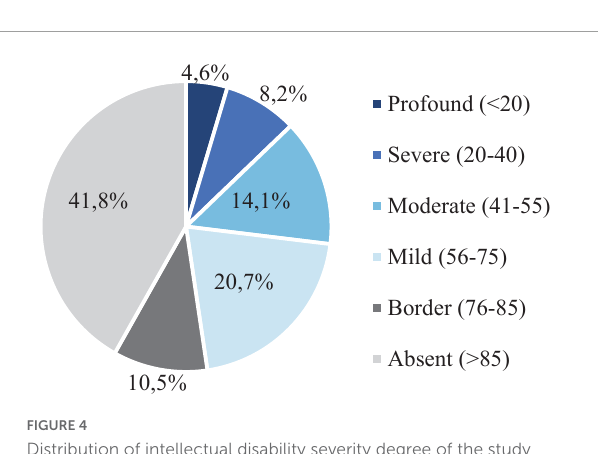
FIGURE4 Distribution of intellectual disability severity degree of the study participants. The level of intellectual disability (ID) according to the intelligence quotient (IQ) test score. ID corresponds to an IQ test score <